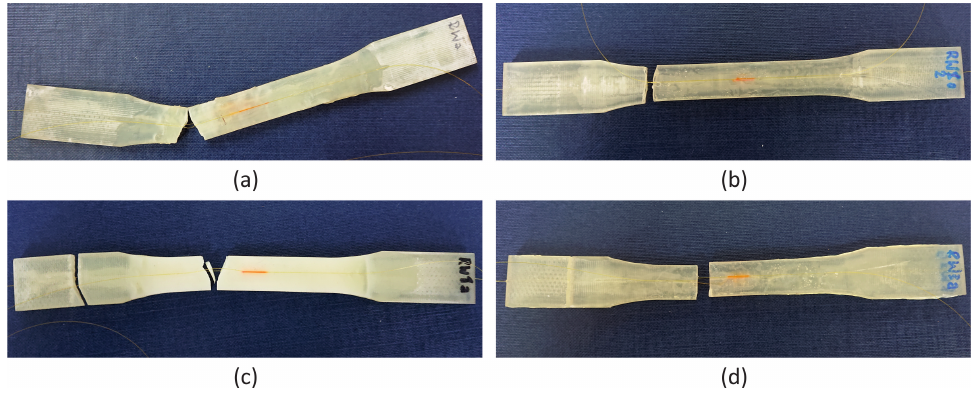
Figure 20. Photographs of samples after the tensile tests: ( a ) M3 X after exposition on elevated temperatures, ( b ) M3 Crystal after exposition on elevated temperatures, ( c ) M3 X after exposition on sub-zero temperatures, and ( d ) M3 Crystal after exposition on sub-zero temperatures.